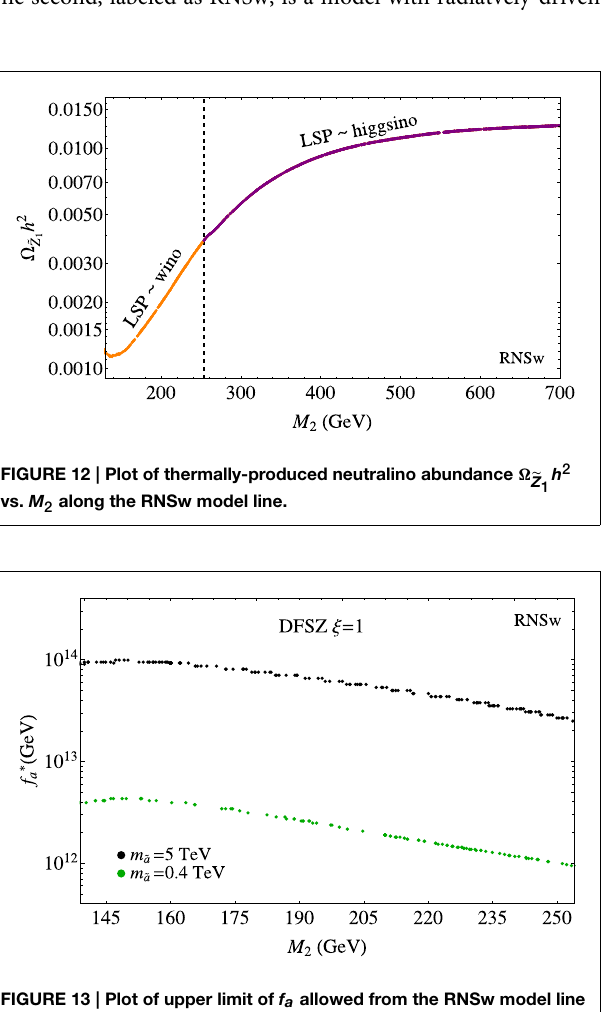
FIGURE 13 | Plot of upper limit of f a allowed from the RNSw model line in the DFSZ case with ξ = 1 vs. M 2 for m ˜ a = 400 GeV and m ˜ a = 5 TeV.